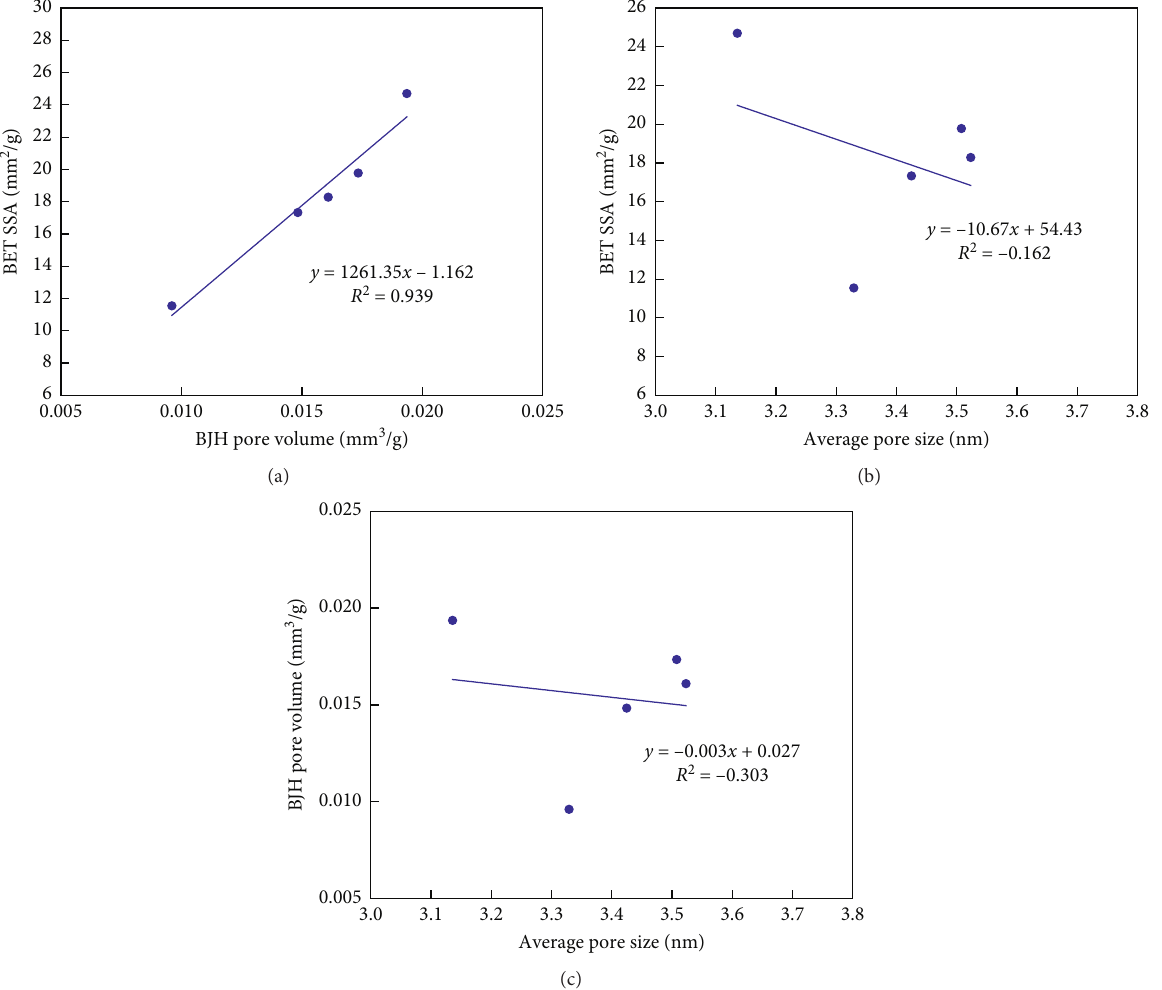
Figure 10: Relationships between (a) BETspecific surface area and BJH pore volume, (b) BETspecific surface area and average pore size, and (c) BJH pore volume and average pore